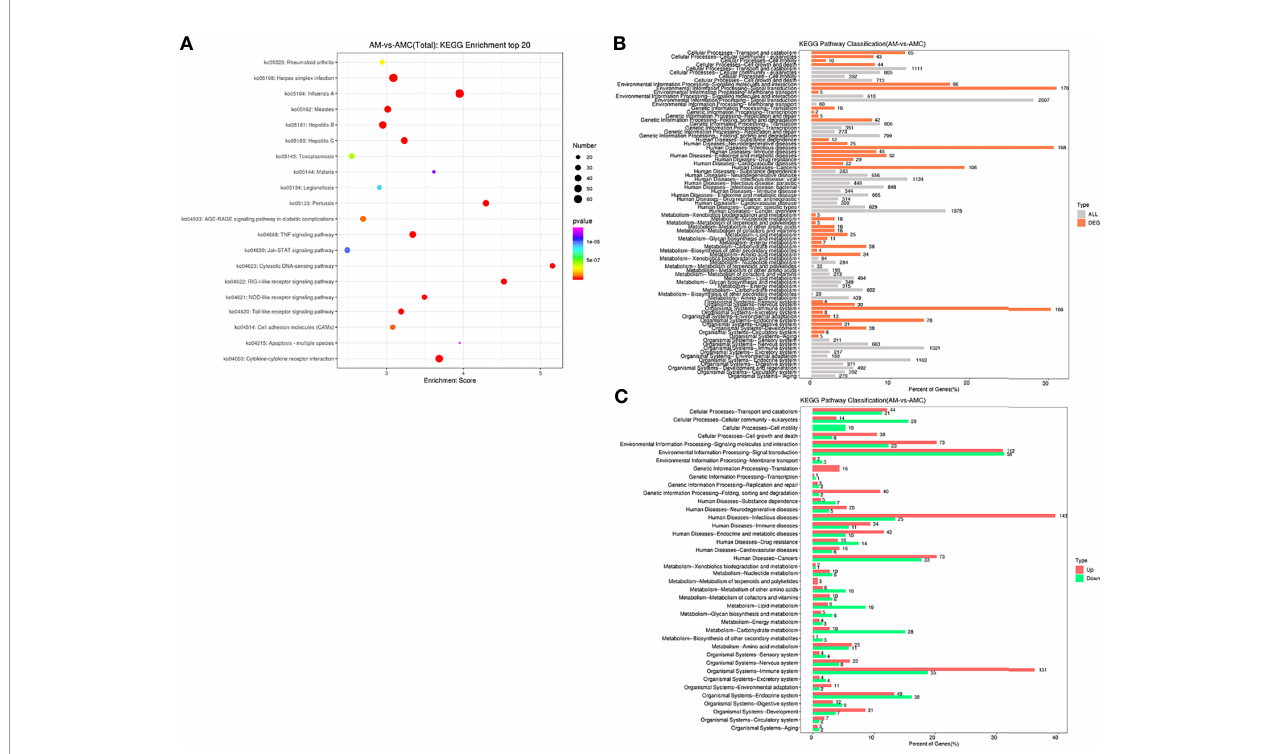
FIGURE 5 | Enrichment analysis of differential gene Unigene. (A) KEGG enrichment top20 pathway bubble chart. The X-axis is the enrichment score, the bubble size indicates the number of unigene contained in the item, and the color of the bubble from purple to red indicates P -value. (B) Distribution comparison of DEGs and all unigene at KEGG level 2. The vertical axis represents the name of level 2 pathway, and the number to the right of the column represents the number of DEGs annotated to that level 2 pathway. (C) Distribution of upregulated and downregulated unigene at KEGG level